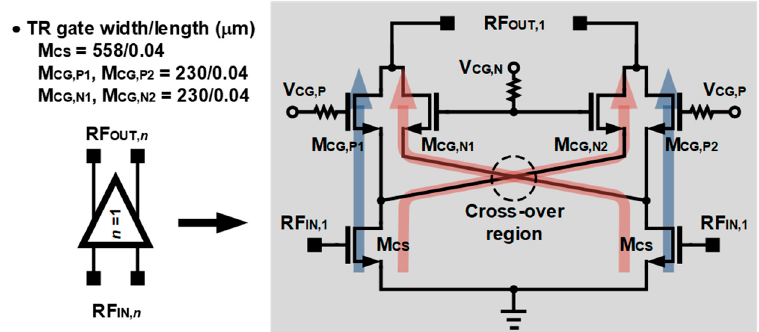
Figure 4. Schematic of the first driver stage with 180° phase-shift function.